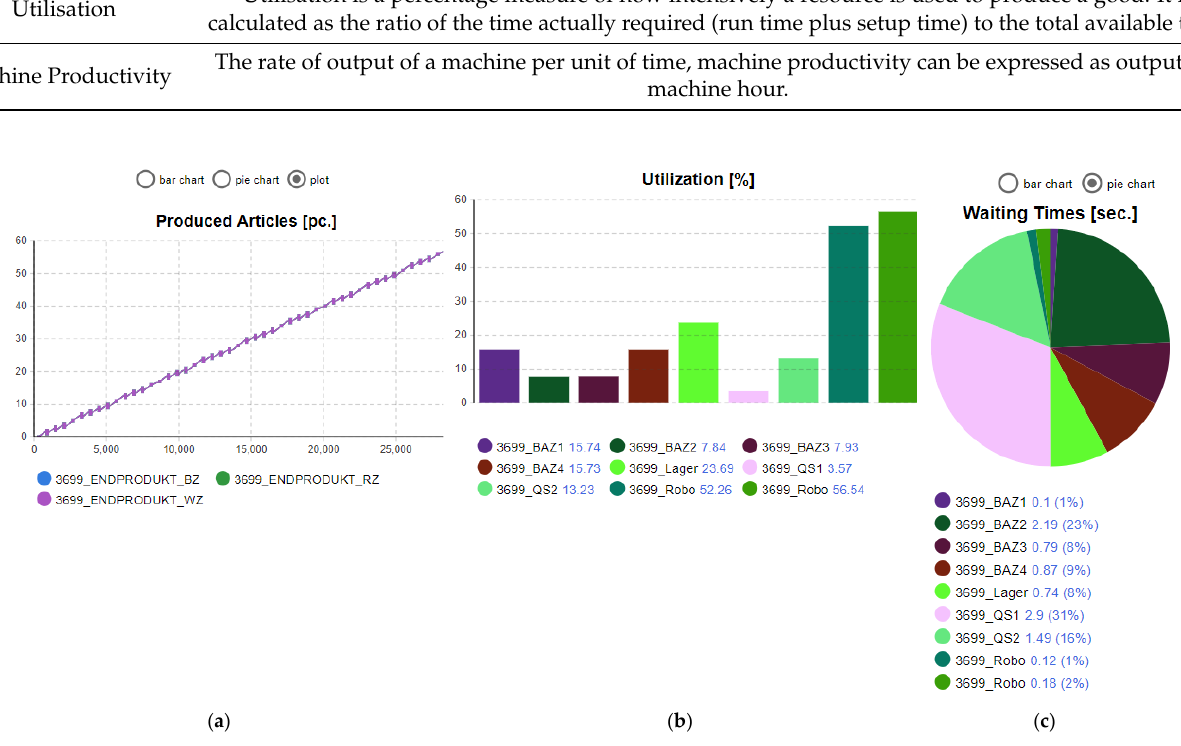
Figure 6. Statistical evaluation with suitable diagrams: ( a ) produced articles as a plot; ( b ) utilisation in percent as a bar chart; ( c ) waiting times as a pie chart.